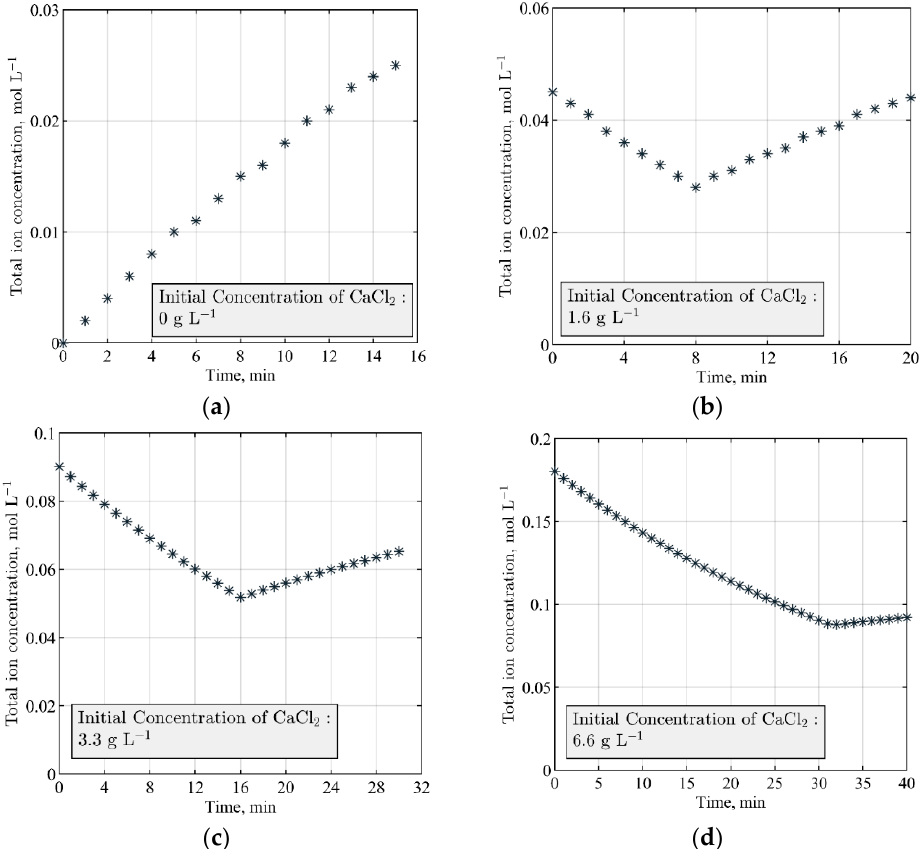
Figure 4. Theoretical modeling and calculation of the total ion balance during the crystallization process. Constant parameters are feed solution pH: 12.1, CO 2 − concentration: 0.14 mol L − 1 , feed addition rate: 40 mL min − 1 . Initial solution volume in the reactor is 3 L. ( a ) No precipitation; ( b ) precipitation until 8 min, afterward calcium chloride is depleted; ( c ) precipitation until 16 min, afterward no calcium chloride is present; ( d ) precipitation until 31 min, afterward no calcium chloride is remaining.